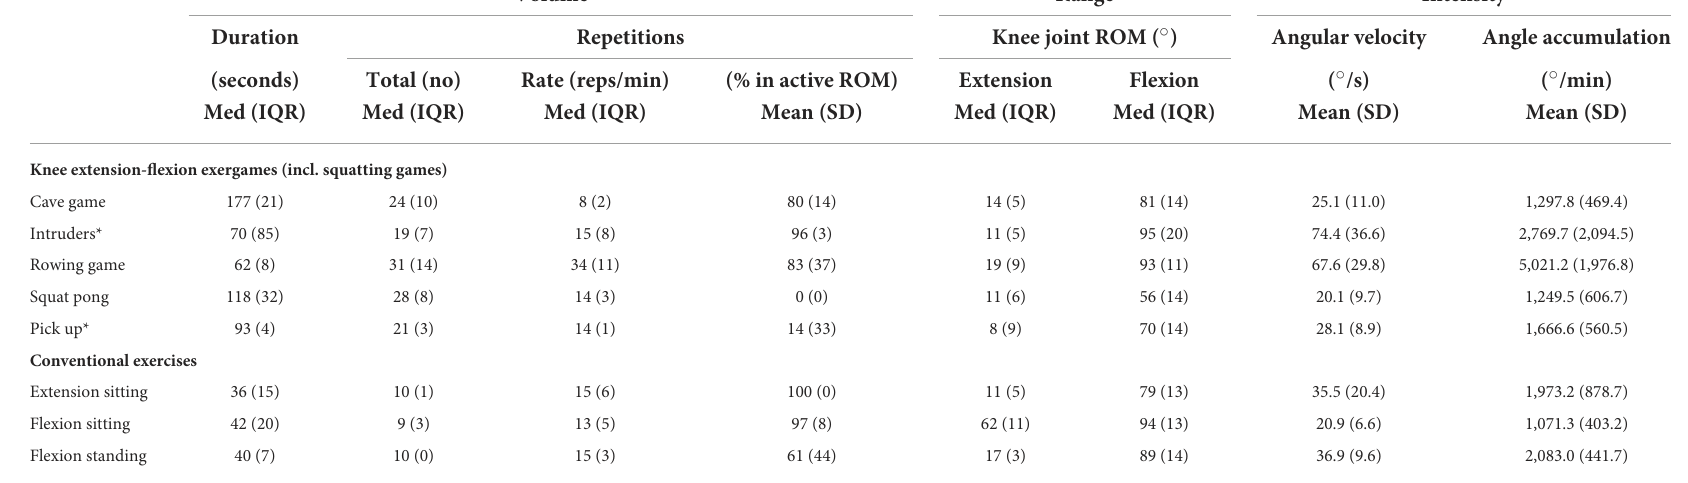
Med, median; IQR, interquartile range; SD, standard deviation; Repetitions; Rate (reps/min), time-proportional rate of repetitions; ROM, rangeof motion; Repetitions; (% in active ROM), repetitions that reachedthe ROM measured with a goniometer